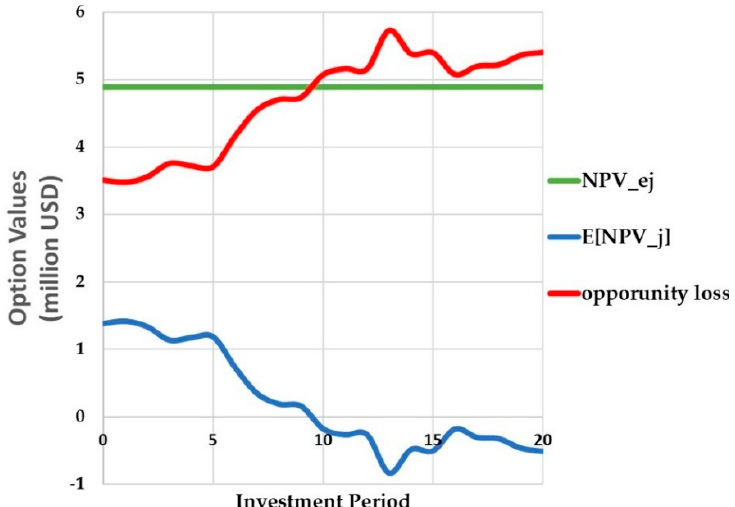
(cid:104) (cid:105) NPV j is the expected NPV of